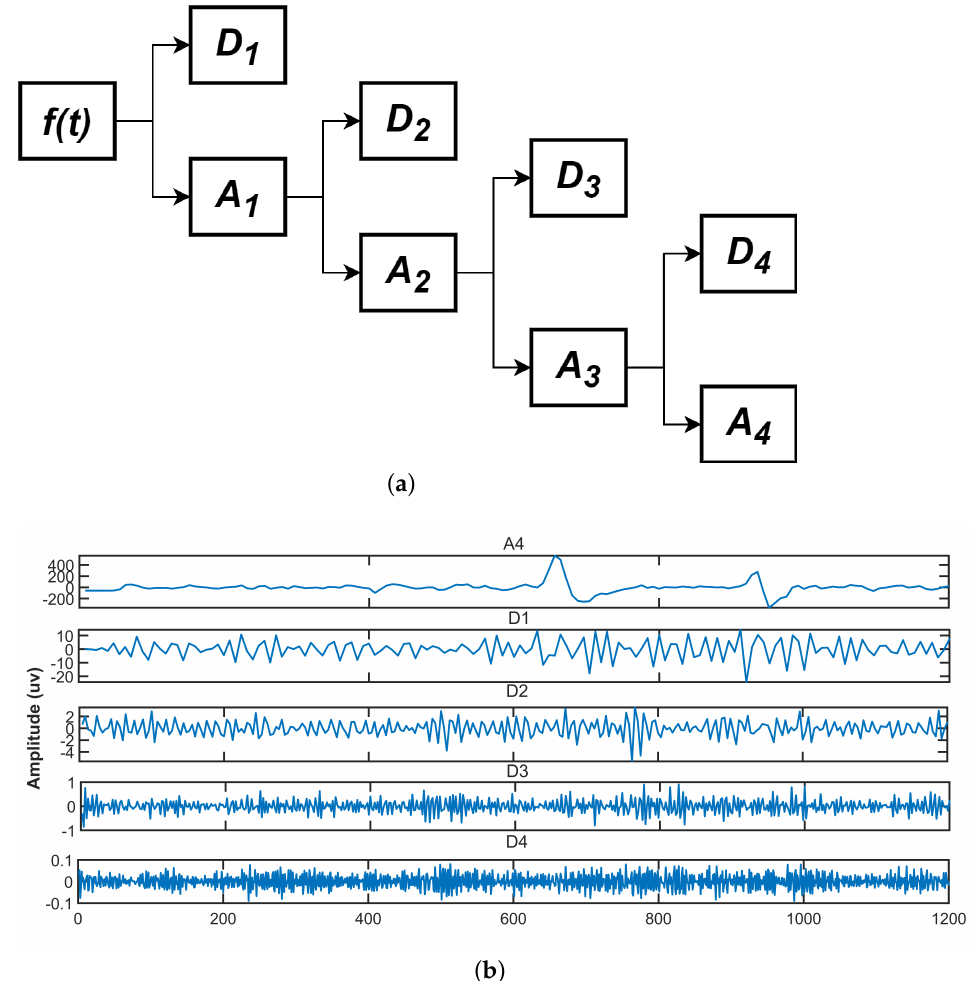
Figure 4. 4-level tree and decomposition of EOG using DWT. ( a ) 4-level DWT of IMF1 signal decomposed by CiSSA. ( b ) Approximate and detailed coefficients of IMF1 using 4-level